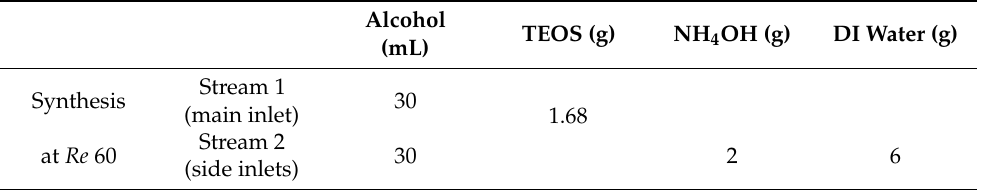
Table 3. Nanoparticle synthesis: A recipe of the nanoparticle synthesis at a flow rate with Re 60.